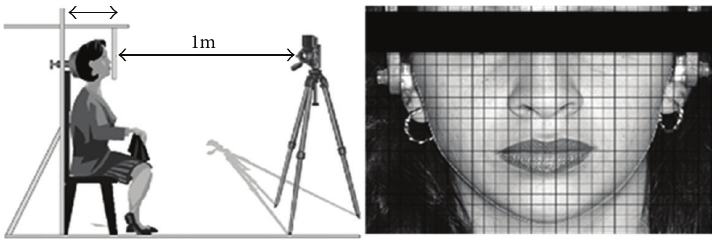
Figure 5: Inflammation measurement by photographic method and